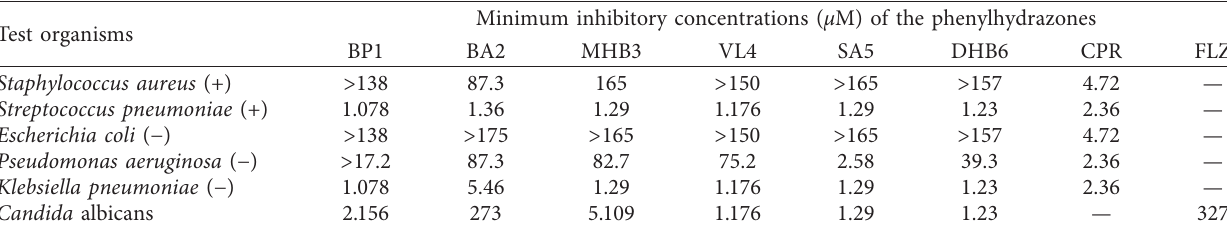
Table 3: Resistant modulatory activity of the compounds against the panel of organisms. Test